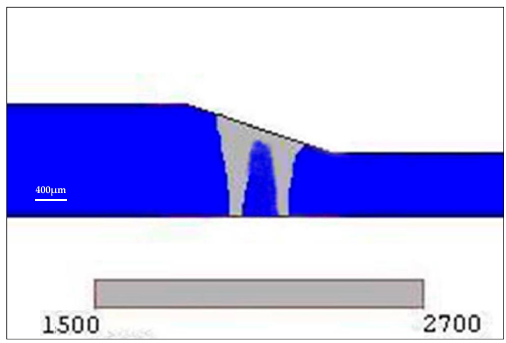
Figure 16. The cross-section of keyholes during dual-beam laser welding of tailored blanks.